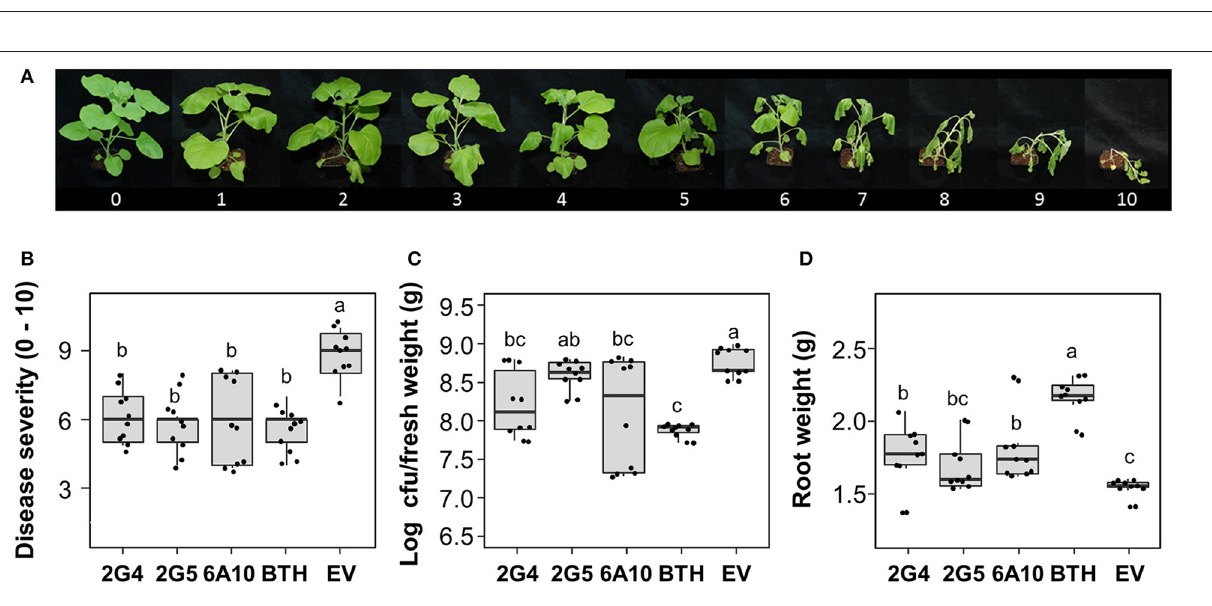
FIGURE 3 | after inoculation with whitefly cDNA clones 2G4, 2G5, and 6A10 on local (left panel) and systemic (right panel) leaves by qRT-PCR. Transcription is shown relative to empty vector (expression level = 1) with the NbActin gene as an internal reference. Bars represent the mean value ± SEM ( N = 10). Infiltration with a suspension of 1mM BTH and Agrobacterium with empty vector (EV) was used as a positive and negative control, respectively. Different letters (a, b, c, and d; w, x, y, and z) within hpa indicate statistically significant differences ( P < 0.05). (C) NtPR1a gene expression pattern following infiltration with candidate effectors using